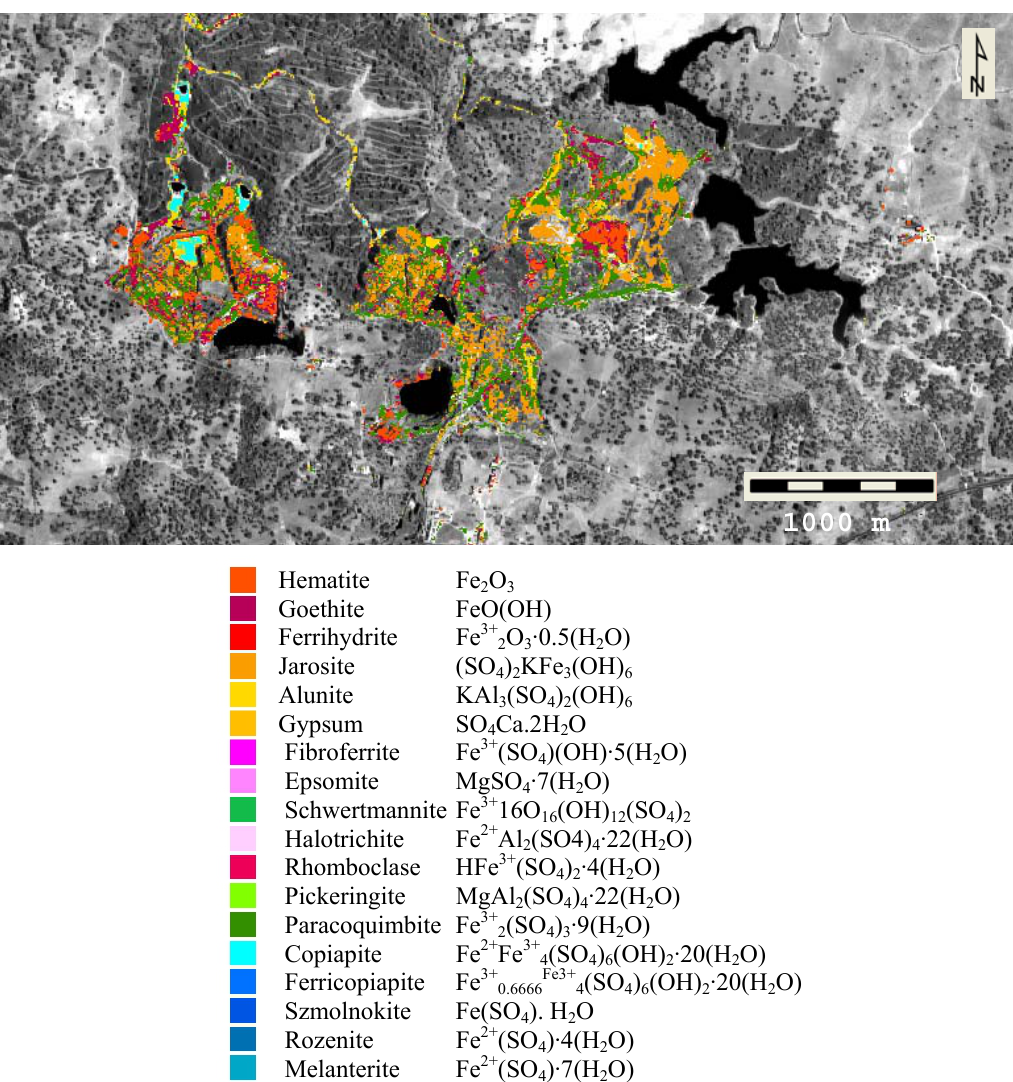
Figure 5. Map of pyrite oxidation products from Hymap data recorded on 13 August 2009, for mine dumps from the Las Herrerias mine site. The legend includes all minerals from the reference spectral library on pyrite weathering products (Crowley et al ., [10]).